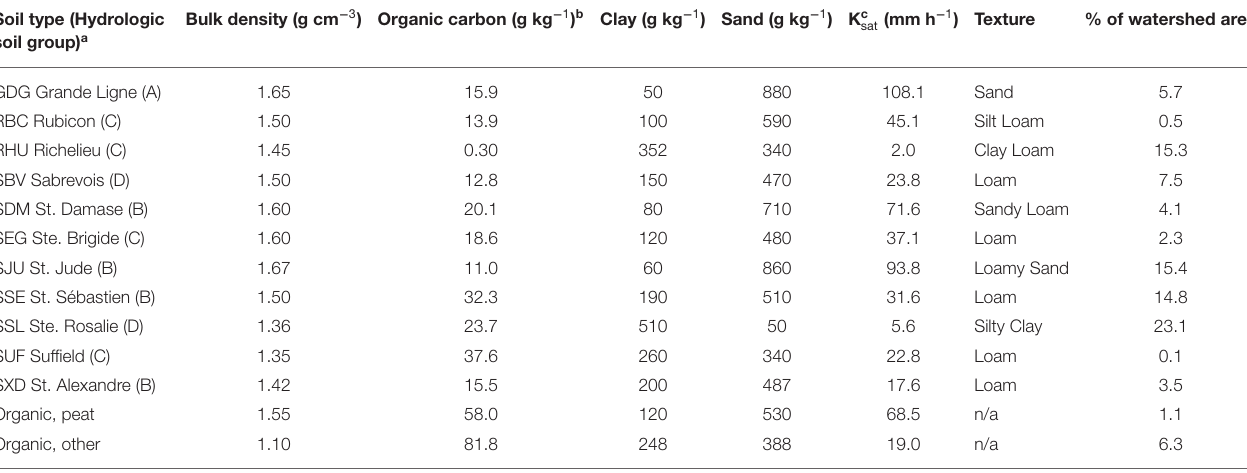
TABLE 1 | Soil types and physico-chemical properties in the surface layer (0–15cm) in the Ewing subwatershed of the Pike River watershed, southern Quebec, Canada. Soil type (Hydrologic soil group)